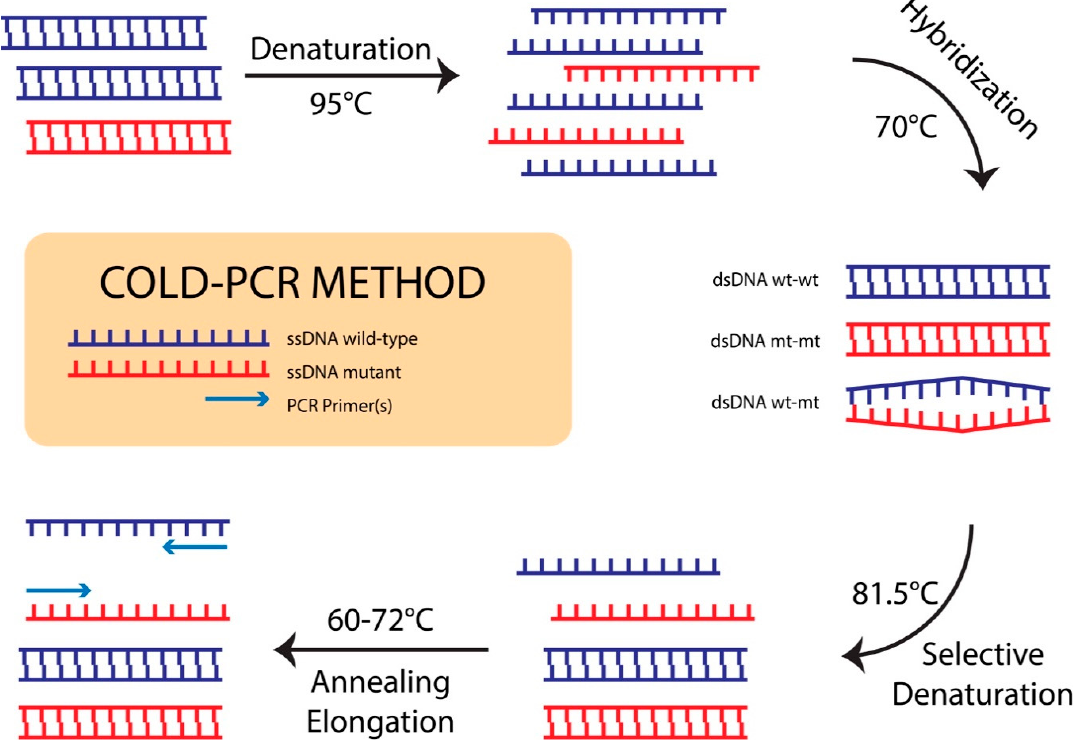
Figure 1. Schematic workflow for co-amplification at lower denaturation temperature (COLD)-PCR: Several rounds of conventional PCR cycles produce the initial material for the target amplicons. After denaturation at 95.0 °C, the PCR amplicons are incubated at 70.0 °C for cross-hybridization. The PCR temperature is raised to the T c (81.5 °C) to preferentially denature the heteroduplex ds DNA wt-mt compared to ds DNA wt-wt or mt-mt, followed by the annealing temperature (60.0 °C), and then increased to 72.0 °C for primer extension, thus preferentially amplifying the mutation-containing alleles.